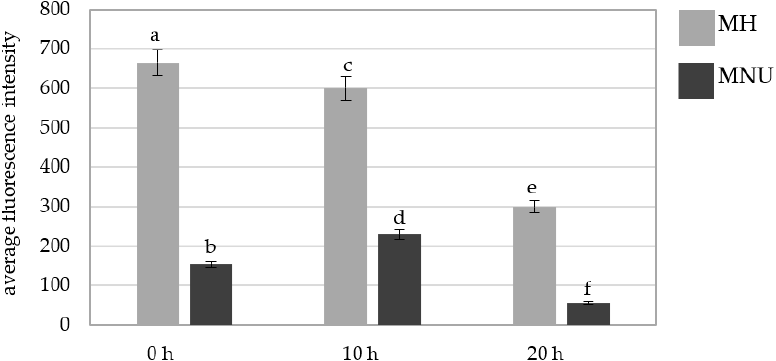
Figure 9. A comparison of the average fluorescence intensity of Alexa 488 that was used to detect 5 mC in the B. distachyon micronuclei in the MH- or MNU-treated cells at different posttreatment times. Fluorescence of Alexa 488 was measured in relative units. ANOVA followed by Tukey HSD test, p < 0.05; mean ± SD, statistically significant differences are indicated by different letters.